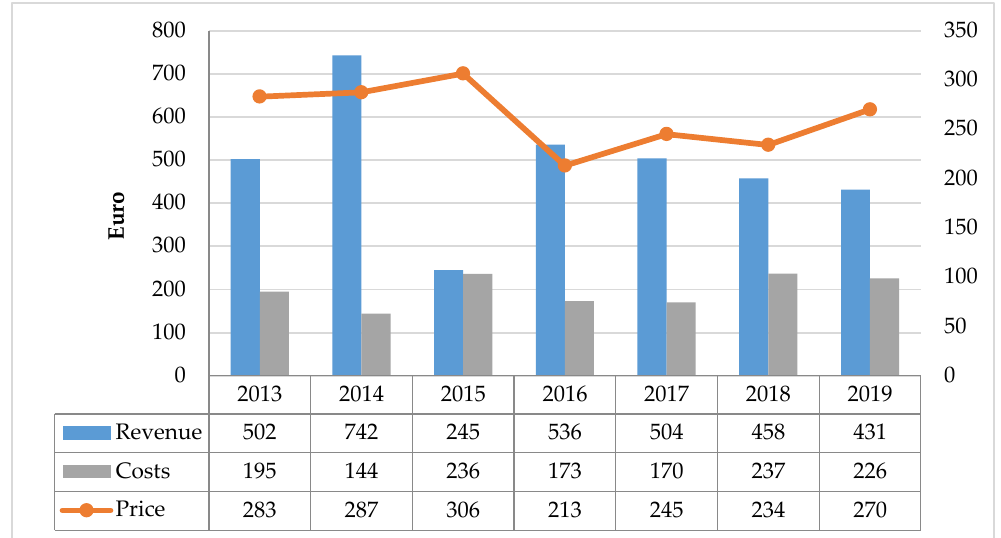
Figure 1. Costs, revenues and prices of durum wheat from seed. By analysing the total costs, we observe a growth trend in the post-adoption period. Below, we analysed the different cost items that made up the total costs to understand the reasons for this variation (Figure 2).